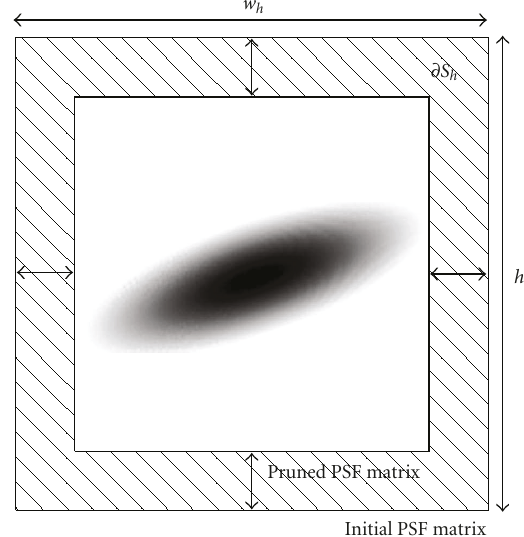
Figure 7: Pruning method for PSF support.